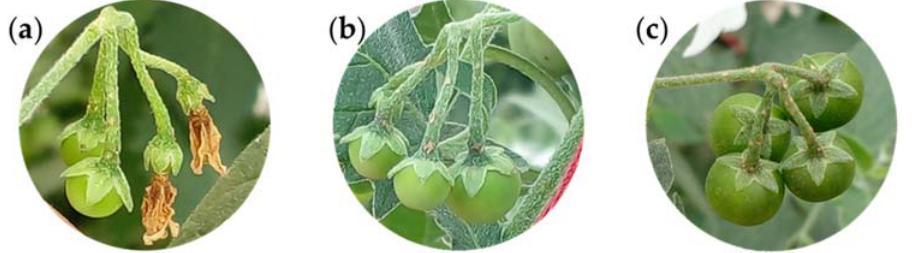
Figure 13. The 50% of fruit of slender nightshade plants ( Solanum nigrescens ) have reached 15 ( a ), 30 ( b ), and 80% ( c ) of their fi nal size. Photos by Sara Monzerrat Ramírez-Olvera.